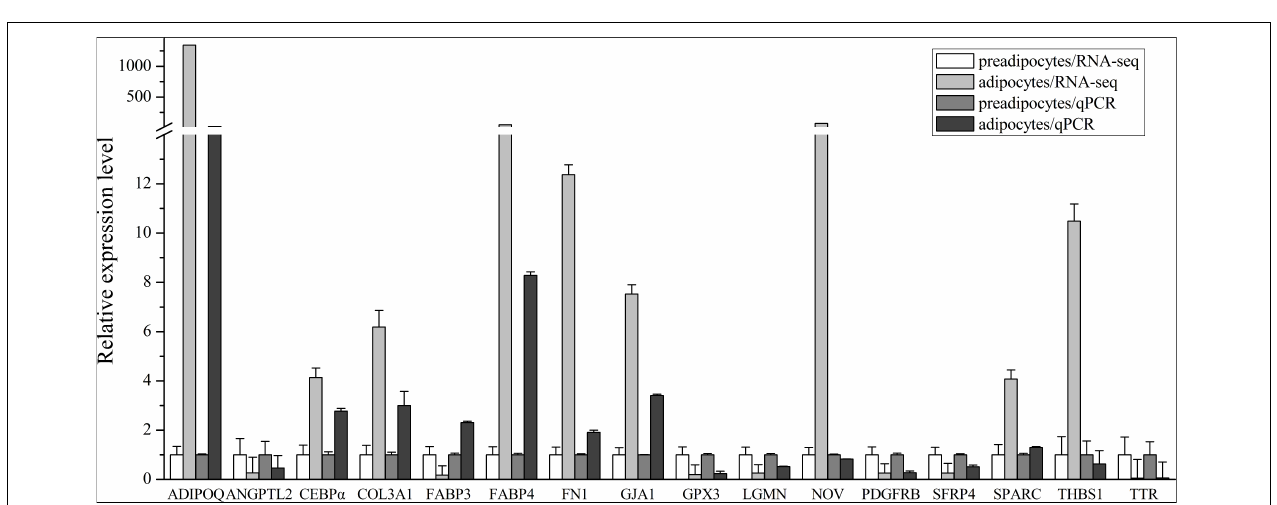
FIGURE 6 | Relative expression level of 16 DEGs selected with high or low expression levels in RNA-seq data and qPCR detection. The expression level in preadipocytes is defined as “1.” In qPCR, all samples were measured in triplicate, and 4 preadipocyte samples and 4 adipocyte samples were used. The data represents mean ± SEM (Standard